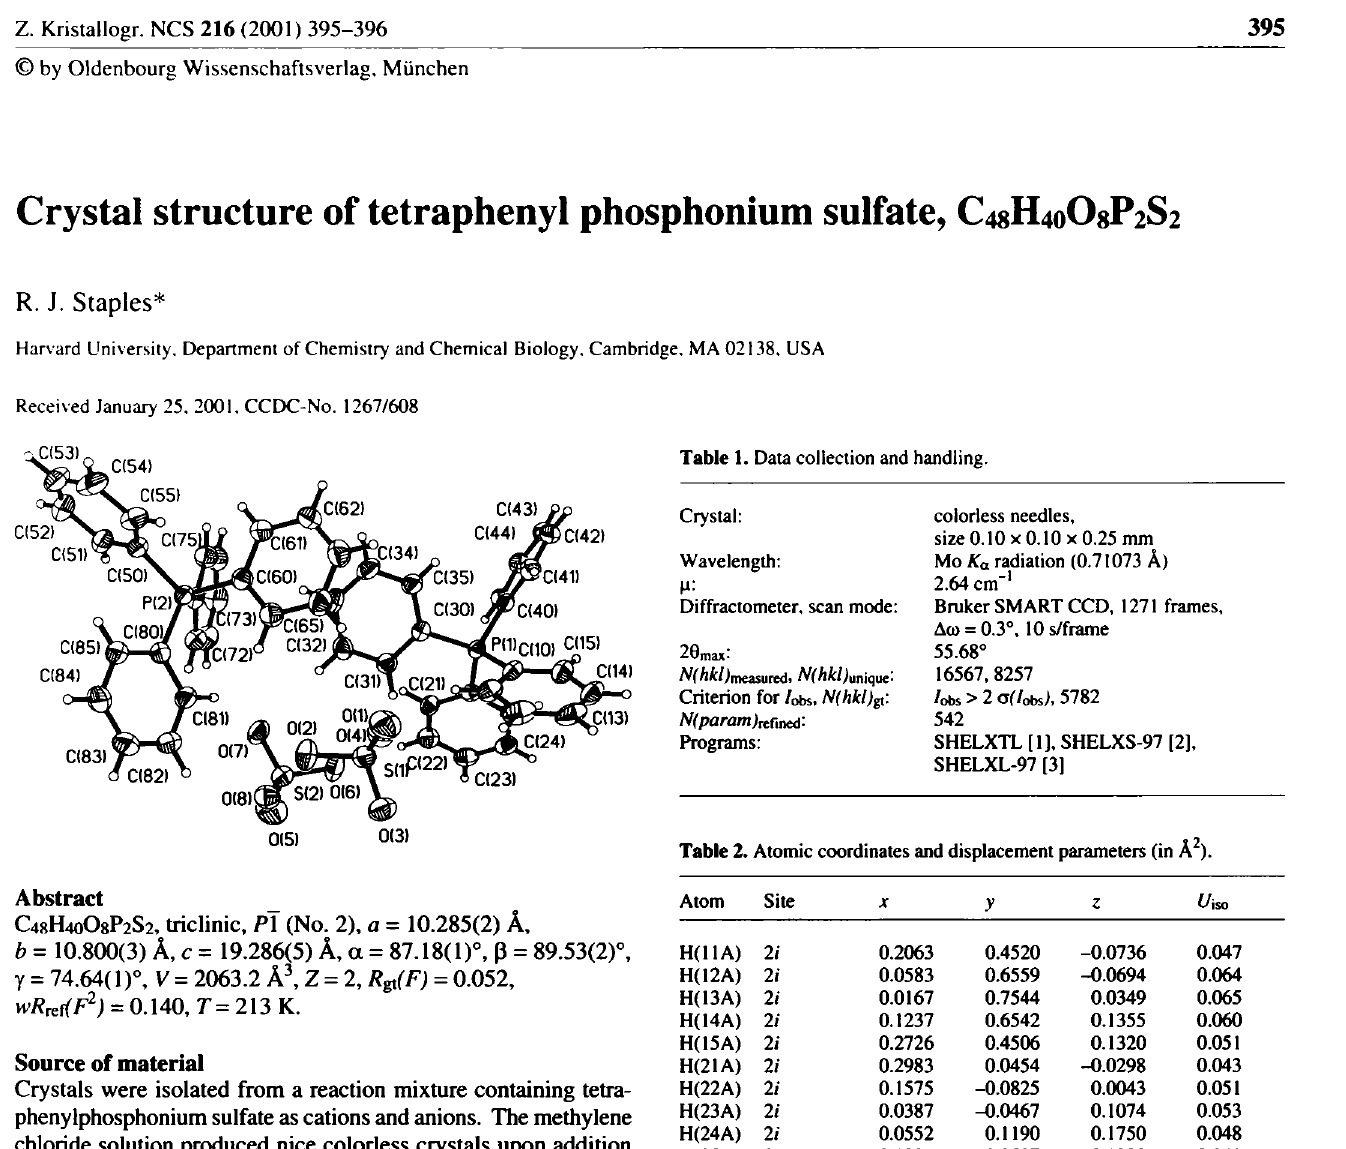
Table 2. Atomic coordinates and displacement parameters (in A 2